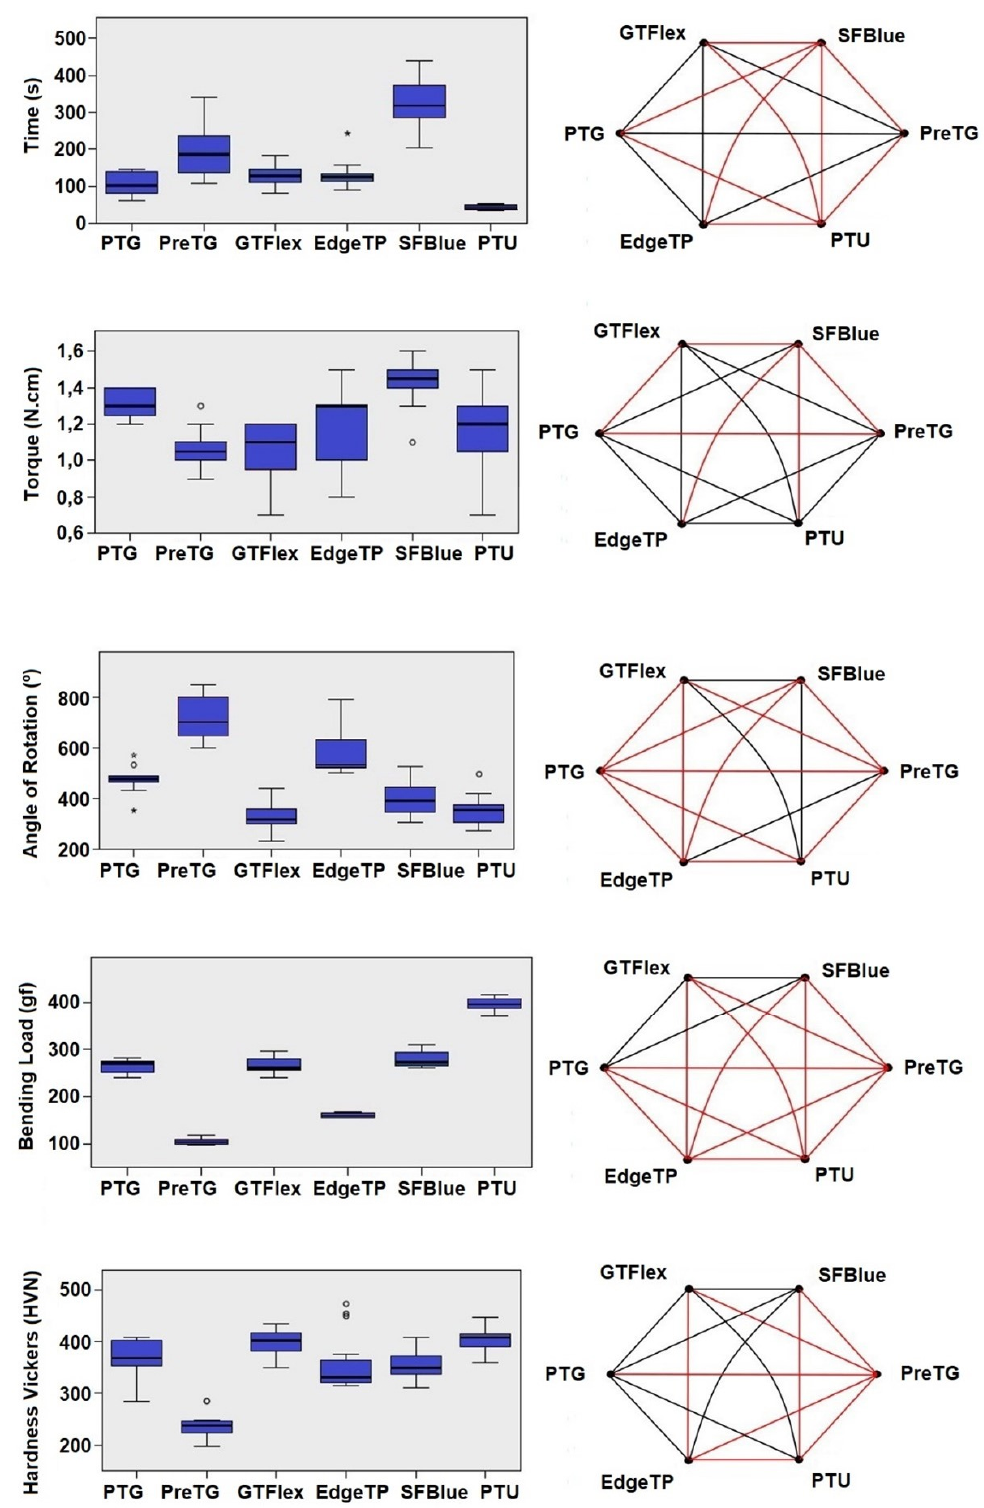
Figure 5. Mechanical performance of the instruments is represented by combined box-and-whisker plots (on the left) of time to fracture, torque, angle of rotation, bending load, and microhardness results, with the line within each box representing the median value. On the right, the diamond graphic details the statistical significance among groups, with the red line representing significant difference ( p < 0.05) (PTG: ProTaper Gold; PreTG: Premium Taper Gold; GTFlex: Go-Taper Flex; EdgeTP: EdgeTaper Platinum; SFBlue: Super Files Blue; PTU: ProTaper Universal).